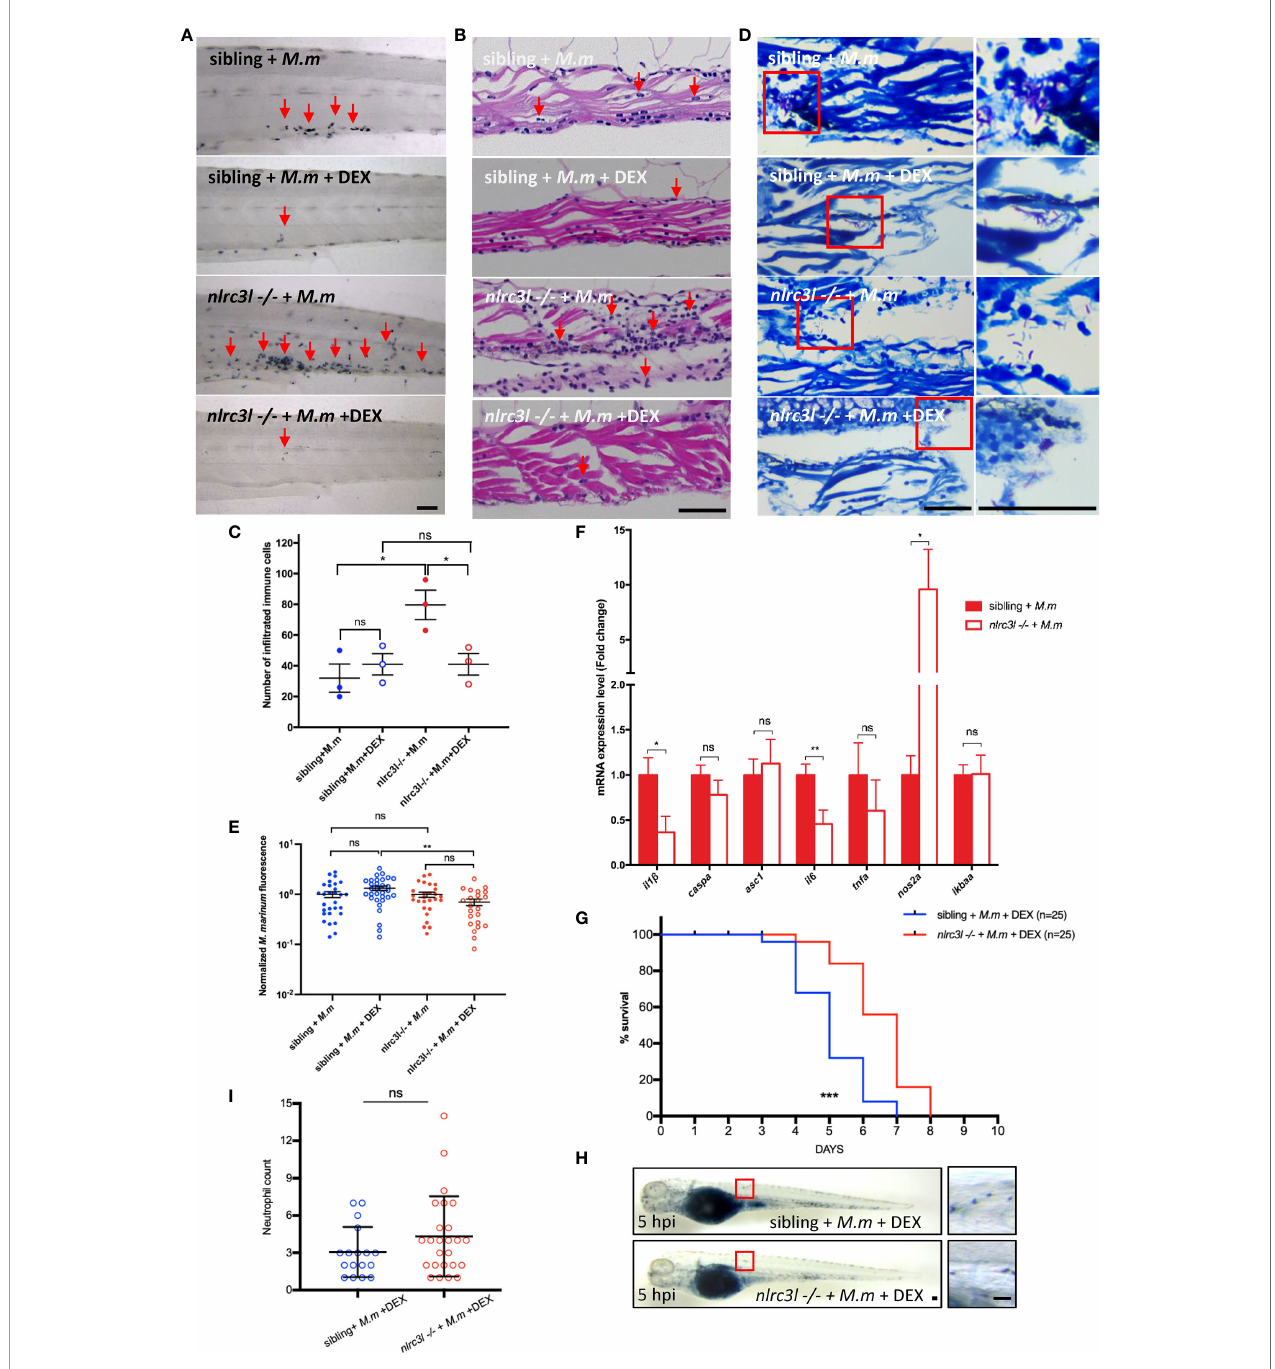
FIGURE 6 | nlrc3-like de fi ciency leads to excessive neutrophils in fi ltration and tissue damage at later stages of infection. (A) SB staining of the tail region in different groups of zebra fi sh embryos. (B) H&E staining of paraf fi n sections of the caudal vein plexus. (C) Quanti fi cation of the number of in fi ltrated immune cells in (B, D) Acid fast staining of paraf fi n sections in the caudal vein plexus. (E) Statistics of normalized bacterial fl uorescence intensity at late stage of infection. (F) Quantitative RT- PCR assessed the expression of multiple cytokines at a late stage of infection (6 dpi). The values are averages from three independent biological repeats, 25 embryos per group in each repeat. (G) Survival curves of infected zebra fi sh with DEX treatment. The data is from one of two similar independent biological replicates (H) . SB staining showing neutrophil recruitment to infection sites at 5 hpi. The left panel shows the whole embryo while the right panel shows an enlargement of the region in the red box that was used for counting neutrophils. (I) Graph showing the number of neutrophils, counted as in (H) . The data shown was combined from three independent biological repeats. (A, B, D, H) Scale bar = 50 m m *p ≤ 0.05; **p ≤ 0.01; ***p ≤ 0.001; ns, not statistically signi fi cant